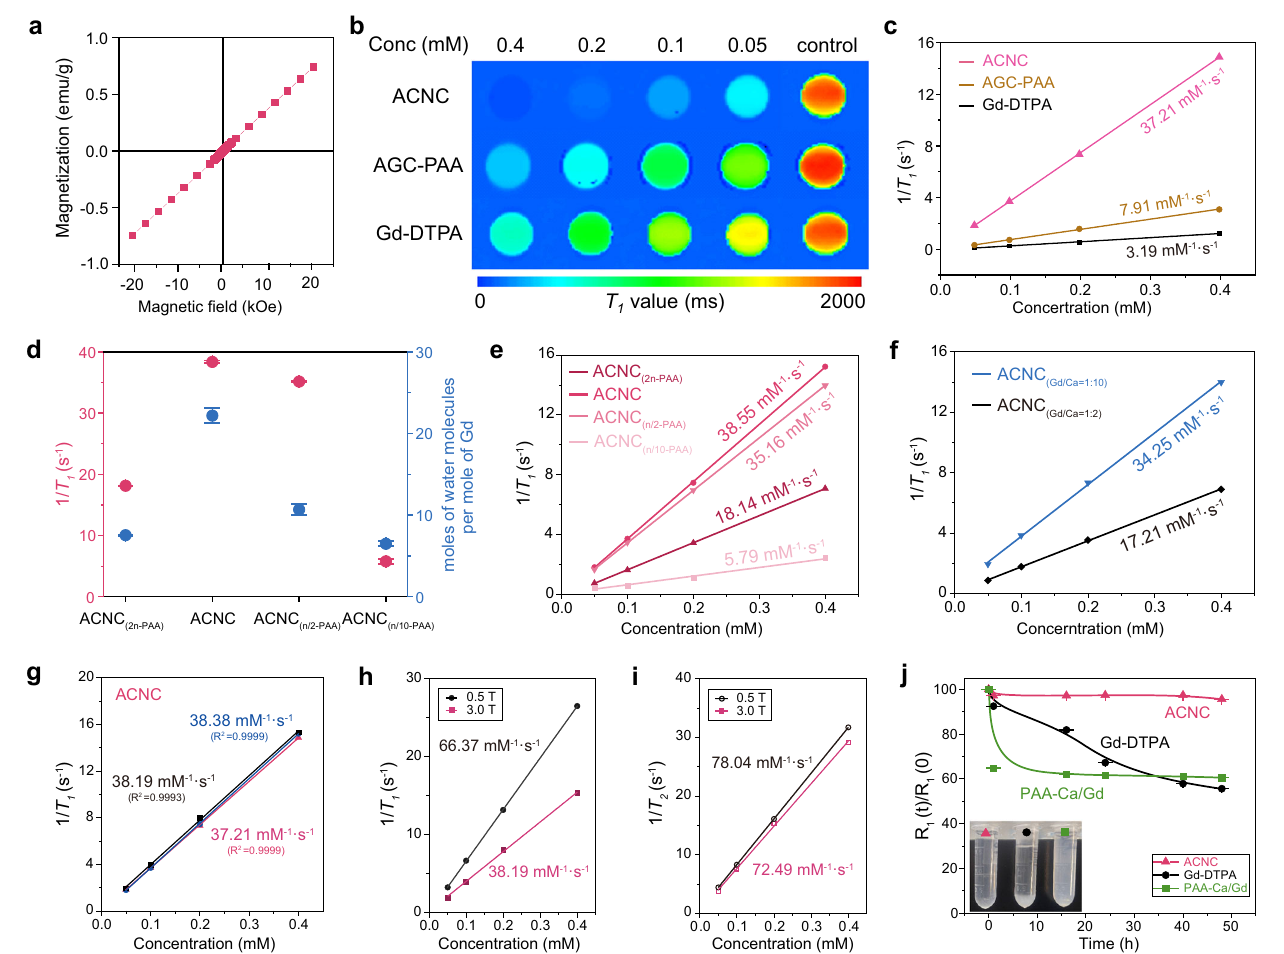
Fig. 3 | MRI performance of ACNC. a M – H curve of ACNC at room temperature. b , c T 1 mapand1/ T 1 versusGdconcentrationcurveofACNC( R 2 =0.9999),AGC-PAA ( R 2 =0.9987) and Gd-DTPA ( R 2 =0.9966) under 3.0T. d Molar ratio of water moleculespermoleofGdand r 1 relaxivityinACNC,ACNC (2n-PAA) ,ACNC (n/2-PAA) and ACNC (n/10-PAA) ( n =3 independent samples). The data show means±SD. e 1/ T 1 ver- sus Gd concentration curve of ACNC ( R 2 =0.9999), ACNC (2n-PAA) ( R 2 =0.9999), ACNC (n/2-PAA) ( R 2 =0.9999) and ACNC (n/10-PAA) ( R 2 =0.9845) under 3.0T. f 1/ T 1